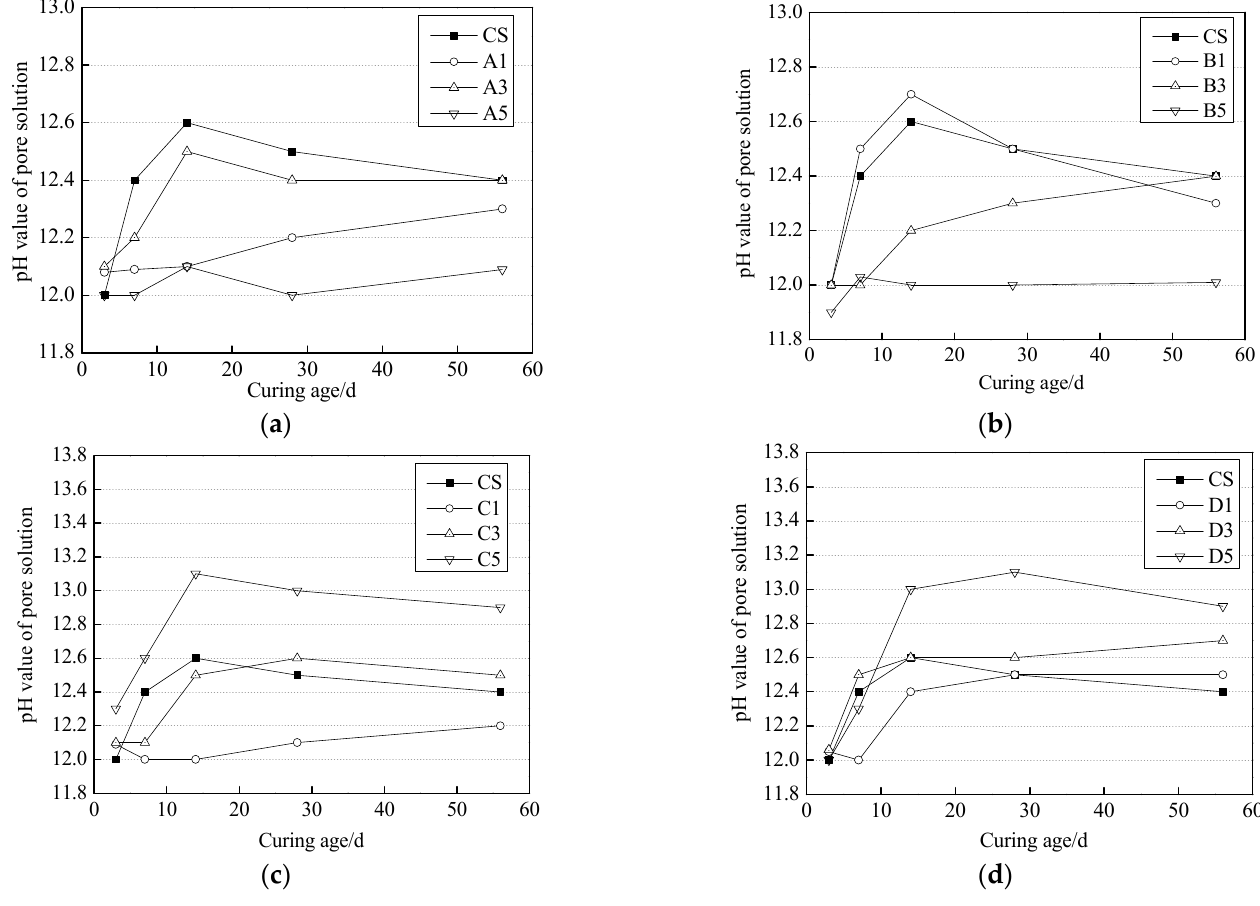
Figure 9. pH value of pore solution in cement paste with NAC after 650 ◦ C calcination. ( a ) Raw ore; ( b ) High-viscosity ore; ( c ) Raw ore under 650 ◦ C calcined; ( d ) High-viscosity ore under 650 ◦ C